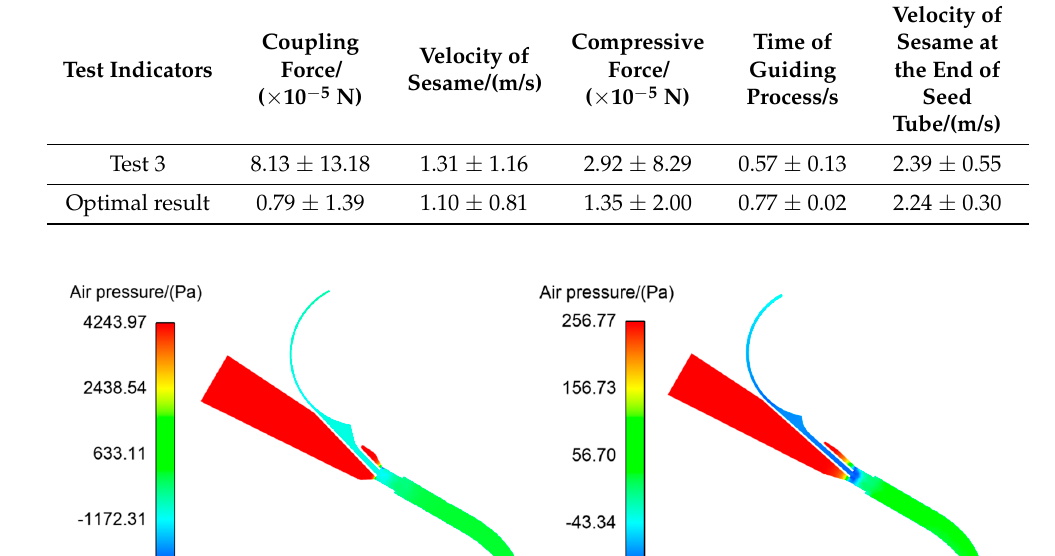
( f ) Figure 12. Force and velocity of seeds in guiding process: ( a ) coupling force in test 3; ( b ) coupling force in optimal result; ( c ) velocity in test 3; ( d ) velocity in optimal result; ( e ) compressive force in test 3; ( f ) compressive force in optimal result.